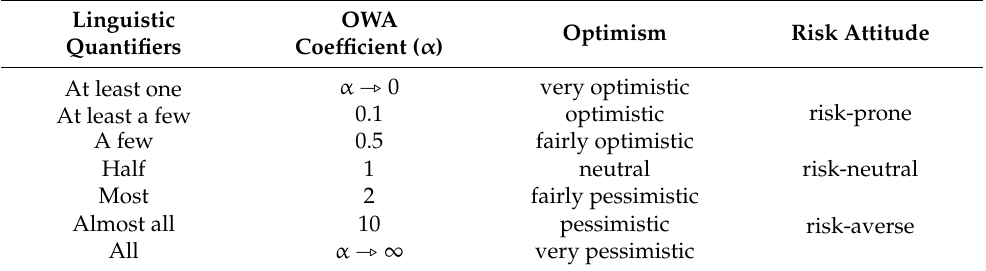
Table 2. OWA linguistic quantifiers [28].